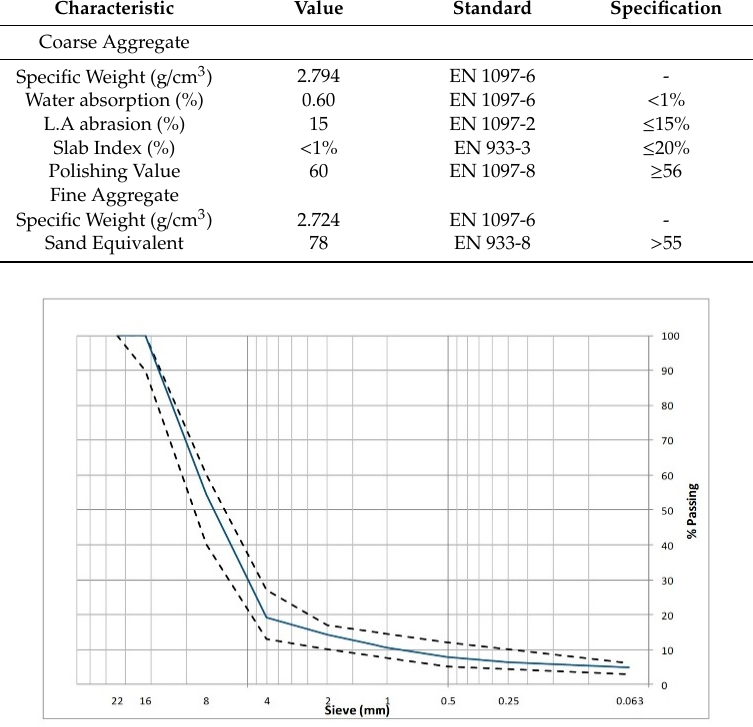
Figure 1. Gradation curve of the PA16 mixture.